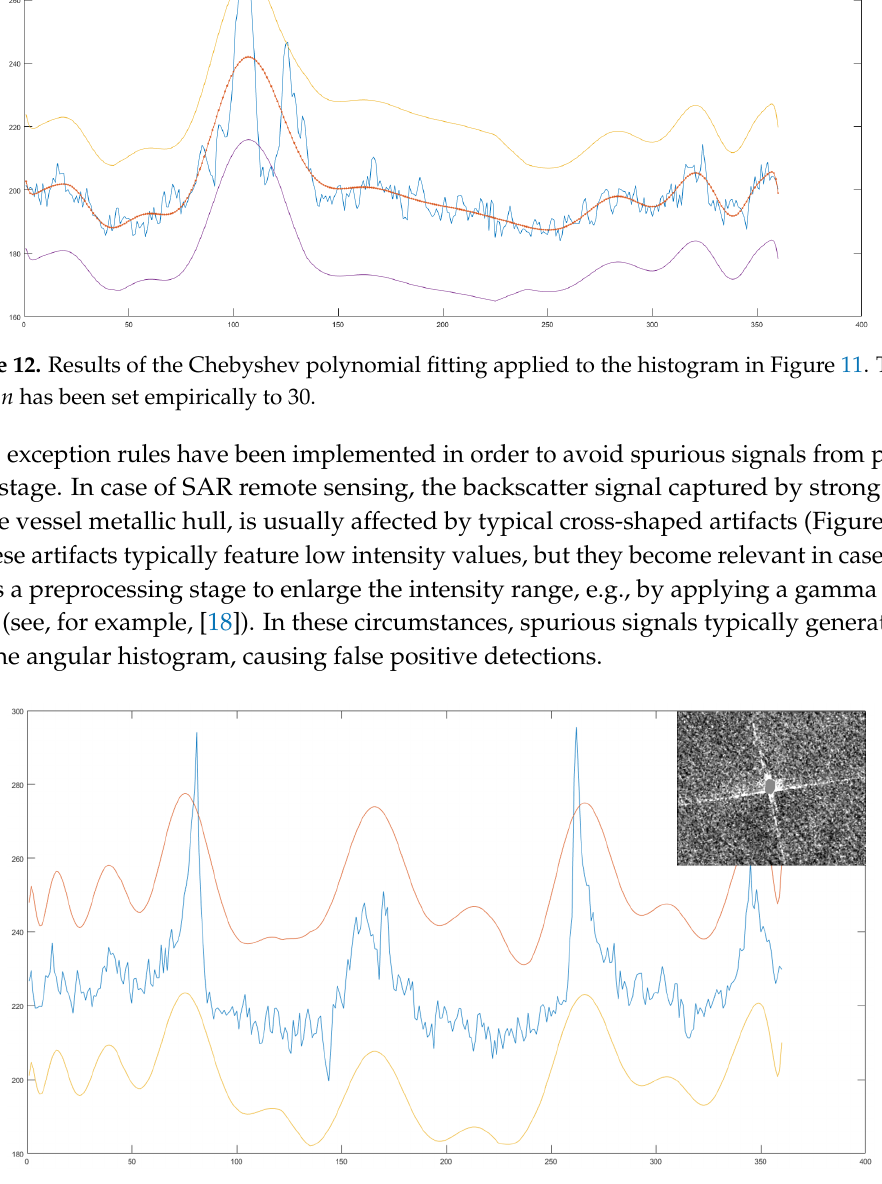
Figure 13. Angular histogram computed on the SAR crop in the upper